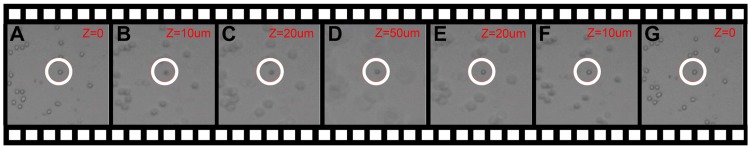
Trapping and moving a silica microsphere axially by an objective lens with much lower NA(0.45).
A–D moving upward, E–G moving backward. (Video S3).